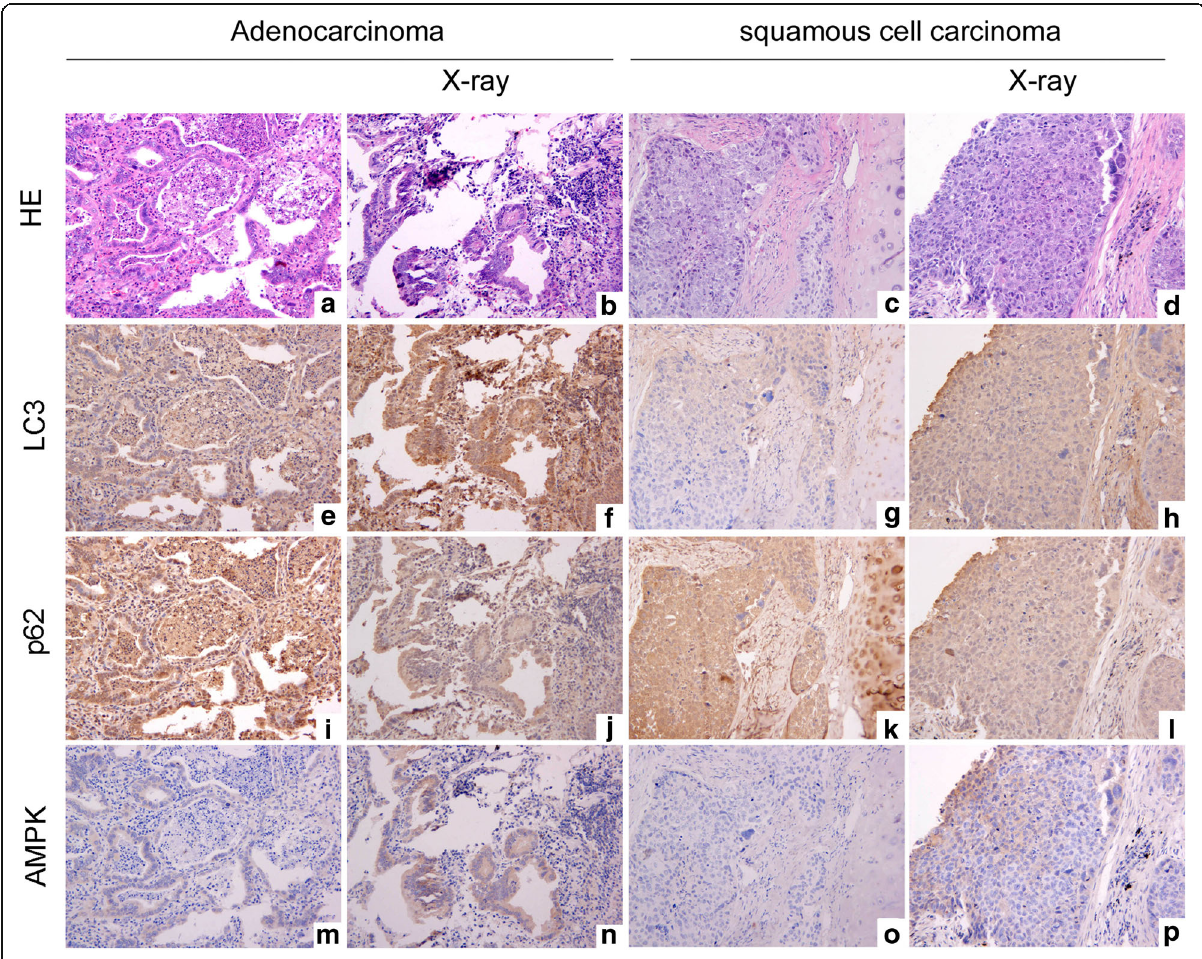
Fig. 3 LC3, P62 and AMPK expression in NSCLC tissues after X-ray irradiation. After 2-Gy X-ray irradiation of the adenocarcinoma samples (moderately differentiated, a and b are stained with HE, 200×), LC3 expression was significantly upregulated ( e is the control, and f indicates LC3 upregulation in the adenocarcinoma samples after X-ray irradiation); p62 expression was downregulated ( i is the control, and j indicates p62 downregulation in the adenocarcinoma samples after X-ray irradiation); and AMPK expression was upregulated ( m is the control, and n indicates AMPK upregulation in the adenocarcinoma samples after X-ray irradiation). After 2-Gy X-ray irradiation of the squamous cell carcinoma samples (poorly differentiated, c and d are stained with HE, 200×), LC3 expression was significantly upregulated ( g is the control, and h indicates LC3 upregulation in the squamous cell carcinoma samples after X-ray irradiation); p62 expression was downregulated ( k is the control, and l indicates p62 downregulation in the squamous cell carcinoma samples after X-ray irradiation); and AMPK expression was slightly upregulated ( o is the control, and p indicates slight AMPK upregulation in the squamous cell carcinoma samples after X-ray